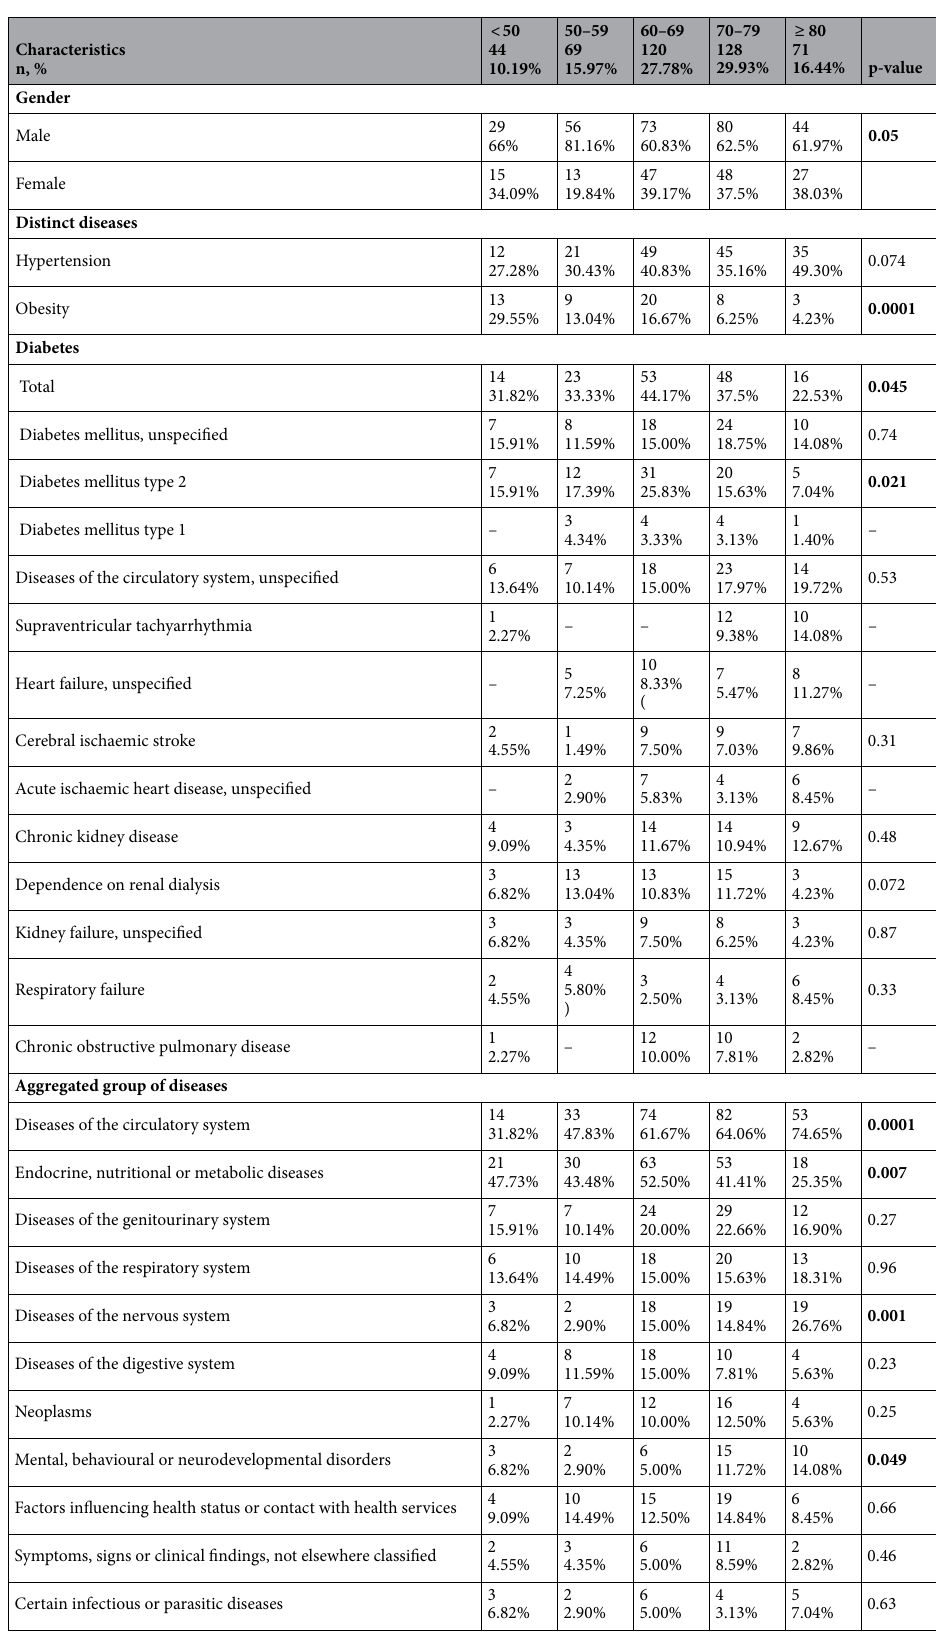
Table 2. Association between age and distinct diseases or group of diseases, as absolute numbers and as percentage. In bold the p-values that reached the statistical